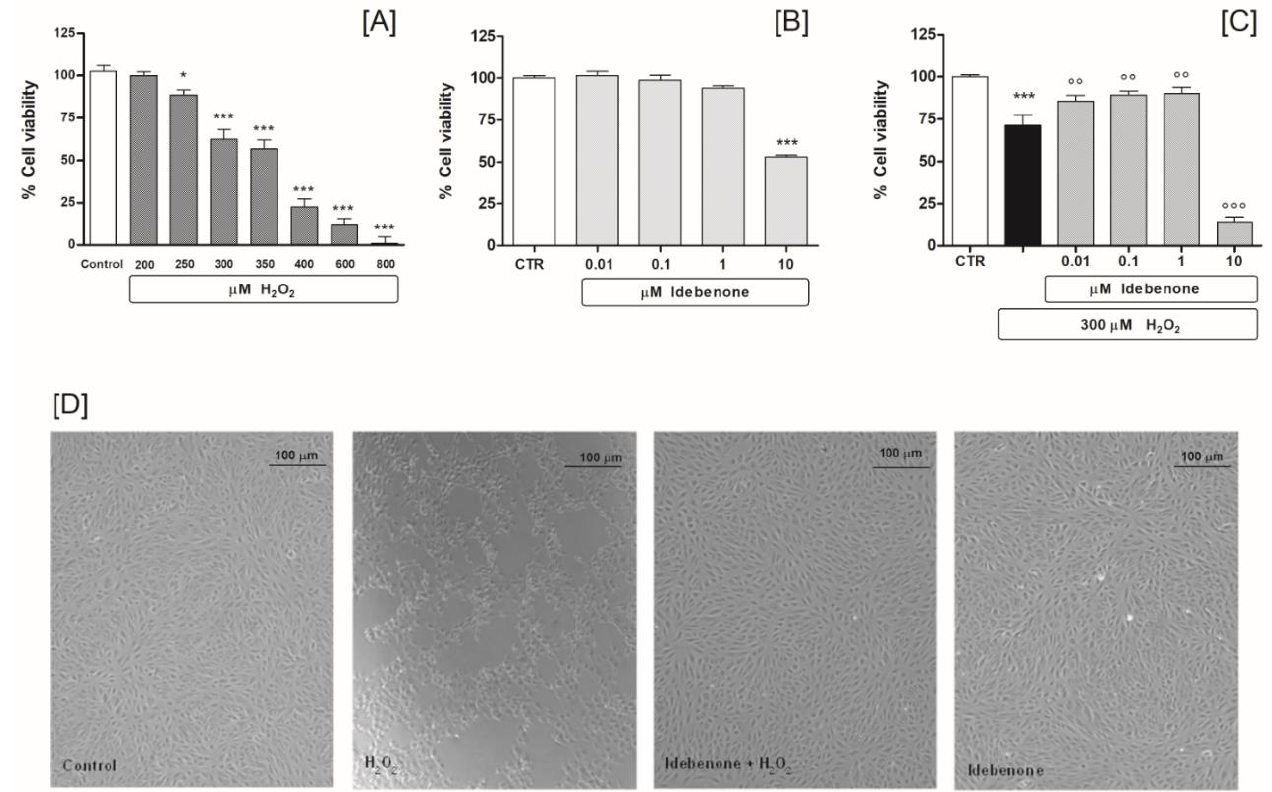
Figure 1. Idebenone pre-treatment diminishes H 2 O 2 –induced cell death. ARPE-19 cell viability: after treatment with different concentrations of H 2 O 2 (range 200–800 µ M) for 24 h ( A ); after idebenone (range 0.01–10 µ M) pre-treatment for 24 h, both under baseline conditions ( B ); and following stimulation with 300 µ M H 2 O 2 ( C ). Phase-contrast micrography shows morphological changes of ARPE-19 cells treated for 24 h with 300 µ M H 2 O 2 in the absence or presence of idebenone (1 µ M) pre-treatment (24 h), compared to the control. Image of idebenone alone is also shown, ( D ). The results are from two independent experiments, each including five replicates per experimental group. Data are expressed as a percentage relative to the untreated cells (control = 100%), the means ± SEM of 10 replicates per group. * p < 0.05 and *** p < 0.001 vs. control; ◦◦ p < 0.01 and ◦◦◦ p < 0.001 vs. H 2 O 2